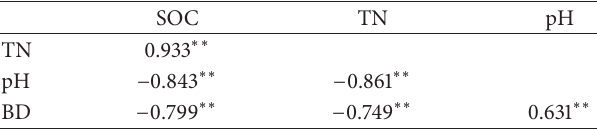
Table 1: Correlation analysis of soil-related variables ( 𝑛 = 27 ).